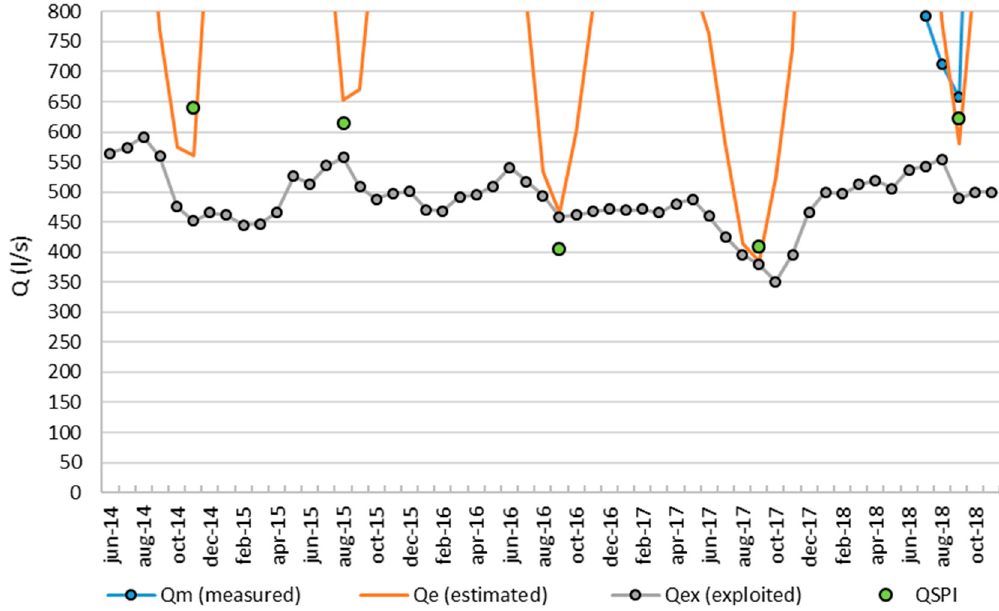
Figure 11. Validation time window: Detail on minimum discharges estimated using the proposed model and the minimum annual discharge estimated ( Q SPI ) using the methodology proposed by [27].